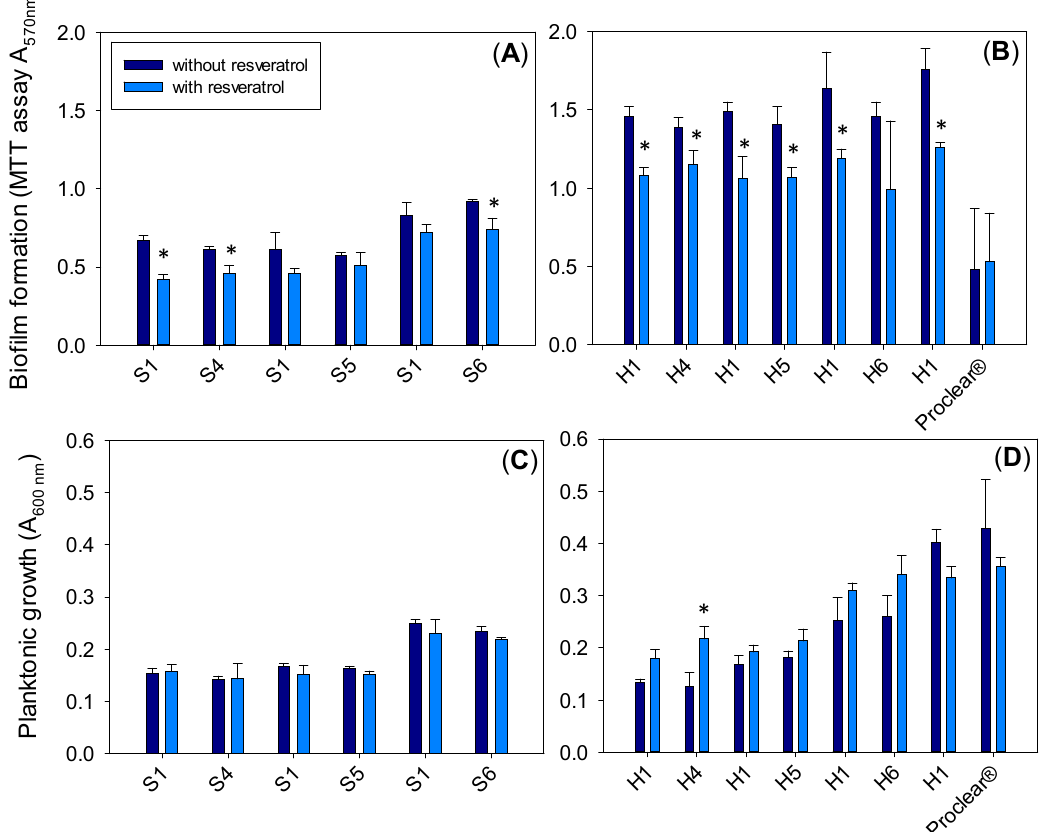
Figure 8. Growth of Pseudomonas aeruginosa PAO1 biofilm on the surfaces of silicone ( A ) and HEMA ( B ) hydrogels (without and with resveratrol) measured with the MTT assay, and in the culture medium surrounding the silicone ( C ) and HEMA ( D ) hydrogels (without and with resveratrol) after 6 h of incubation. * indicates a statistically significant difference between hydrogels with and without resveratrol ( p < 0.05). In each experiment, a silicone hydrogel prepared with MPC (S4, S5 and S6) was evaluated in parallel to the silicone hydrogel without MPC (S1). Similarly, the HEMA hydrogels prepared with MPC (H4, H5 and H6) were evaluated in parallel to the HEMA hydrogel without MPC (H1).